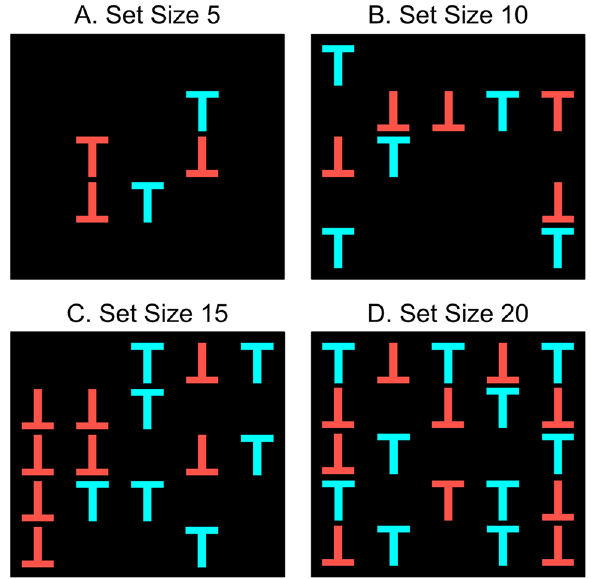
Figure 2. Conjunction search task. Participants were presented with an array of orange letter Ts, orange Ts that were presented upside-down, and blue Ts. The stimuli were presented in set sizes 5, 10, 15, and 20 (Panels A through D). Participants were instructed to look for an orange T and ignore all other